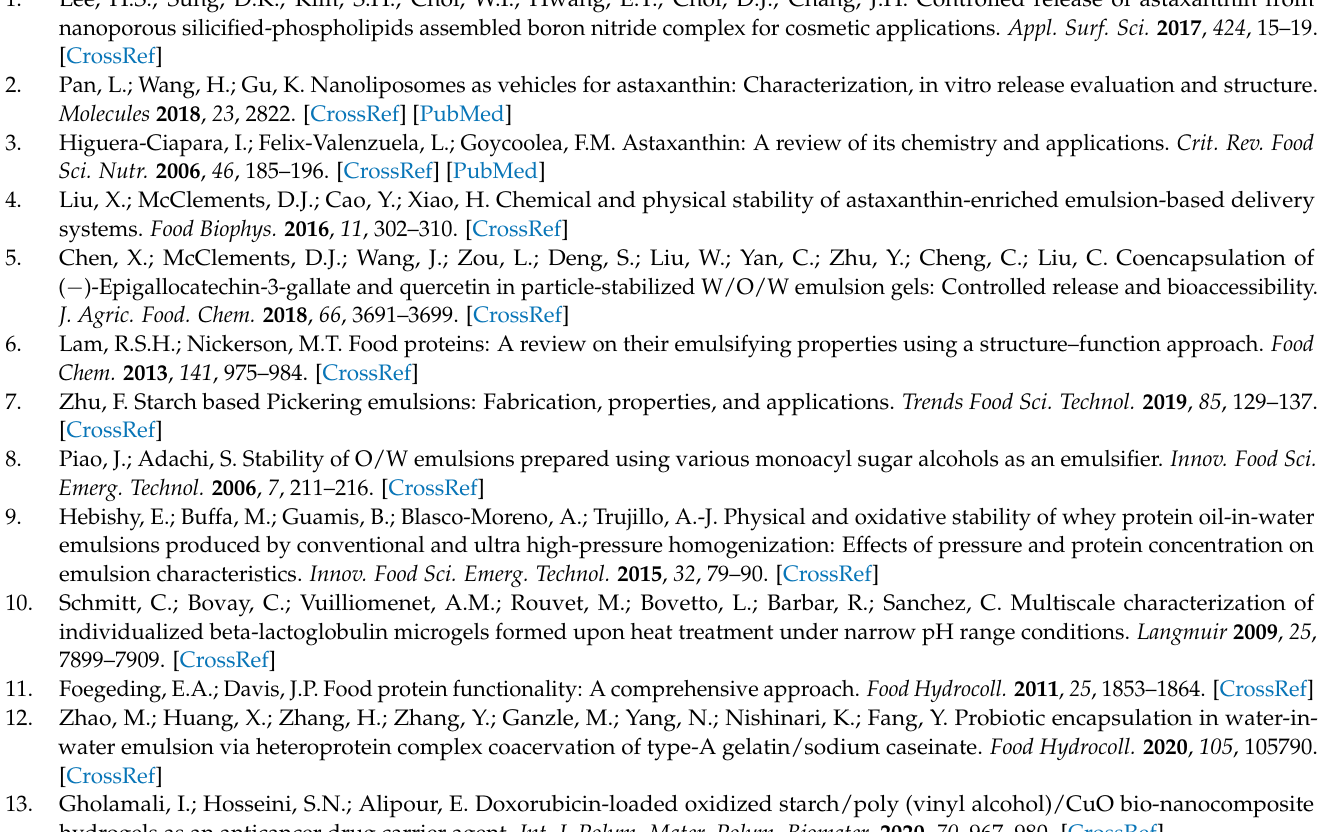
Table S2: Apparent constants of the fitting curve based on the rheological data from OS/ β -lg complex stabilized emulsions at different particle total concentrations, oil/water ratios, and NaCl concen- trations (Herschel–Bulkley model); Figure S1: FT-IR spectra of native starch and oxidized starch; Figure S2: Zeta-potential of OS-0.72 at different concentrations. Bars with different letter superscripts are significantly different at p < 0.05; Figure S3: Zeta-potential of native starch and OS at different pH conditions; Figure S4: Zeta-potential of β -lg at different pH conditions; Figure S5: Isothermal titration calorimetric determination on the binding of OS-0.72 to β -lg at the mixing ratio of 2:10 (pH 3.6); and Figure S6: Calibration curve of astaxanthin (0.1% w / v ) in MCT oil